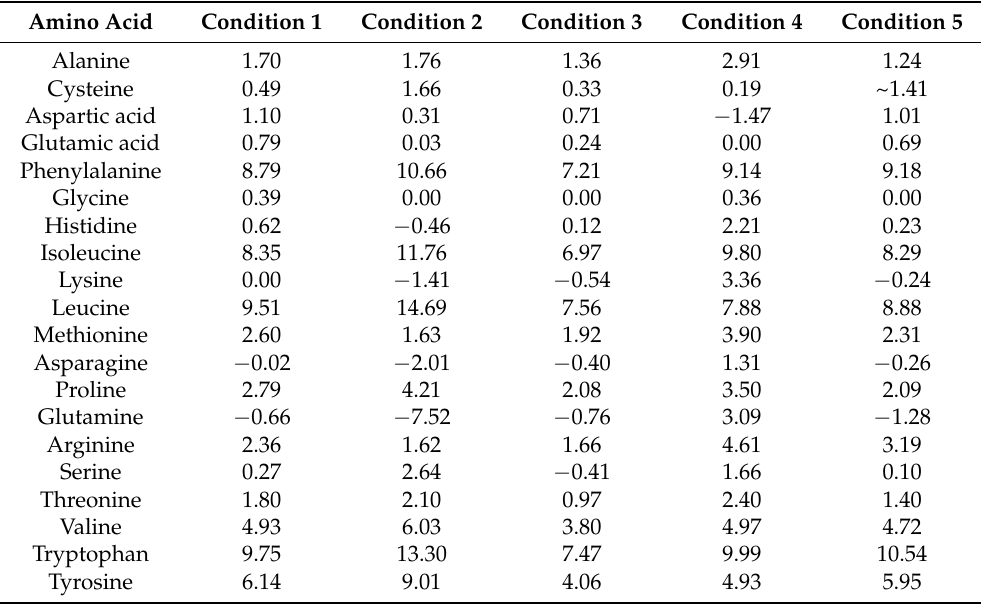
Table 3. Estimated amino acid retention coefficients in five different chromatographic conditions